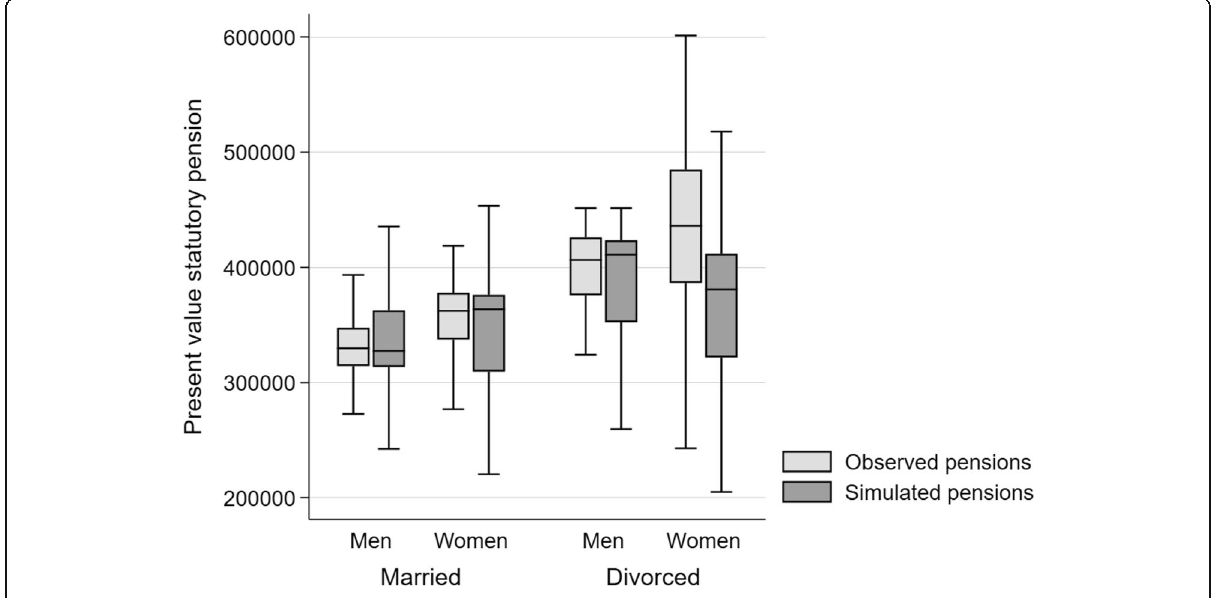
Fig. 3 Accuracy of simulated statutory pension wealth for non-retired individuals by civil status Note: individuals who reached ordinary retirement age between 2012 and 2014 ( n = 283 men, 298 women). Source: linked data from SILC 2015 and administrative records, own calculation